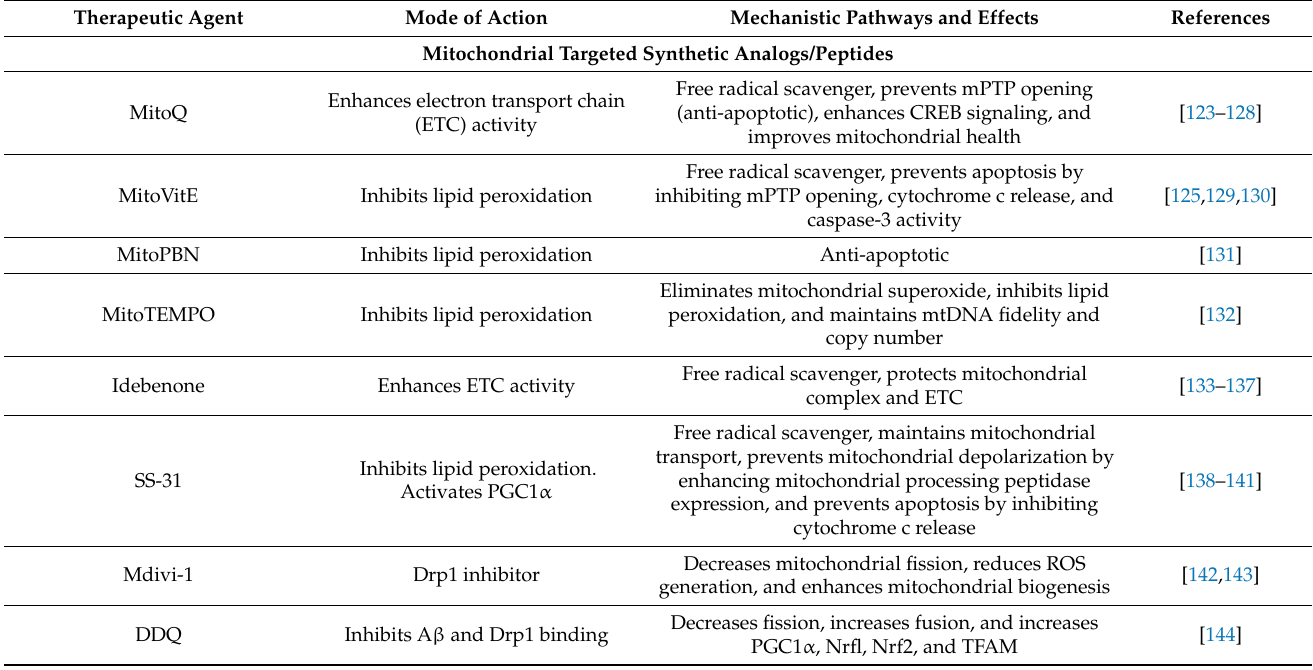
Table 1. Main therapeutic agents and strategies targeting mitochondria that have been explored to improve cognition and memory defects in